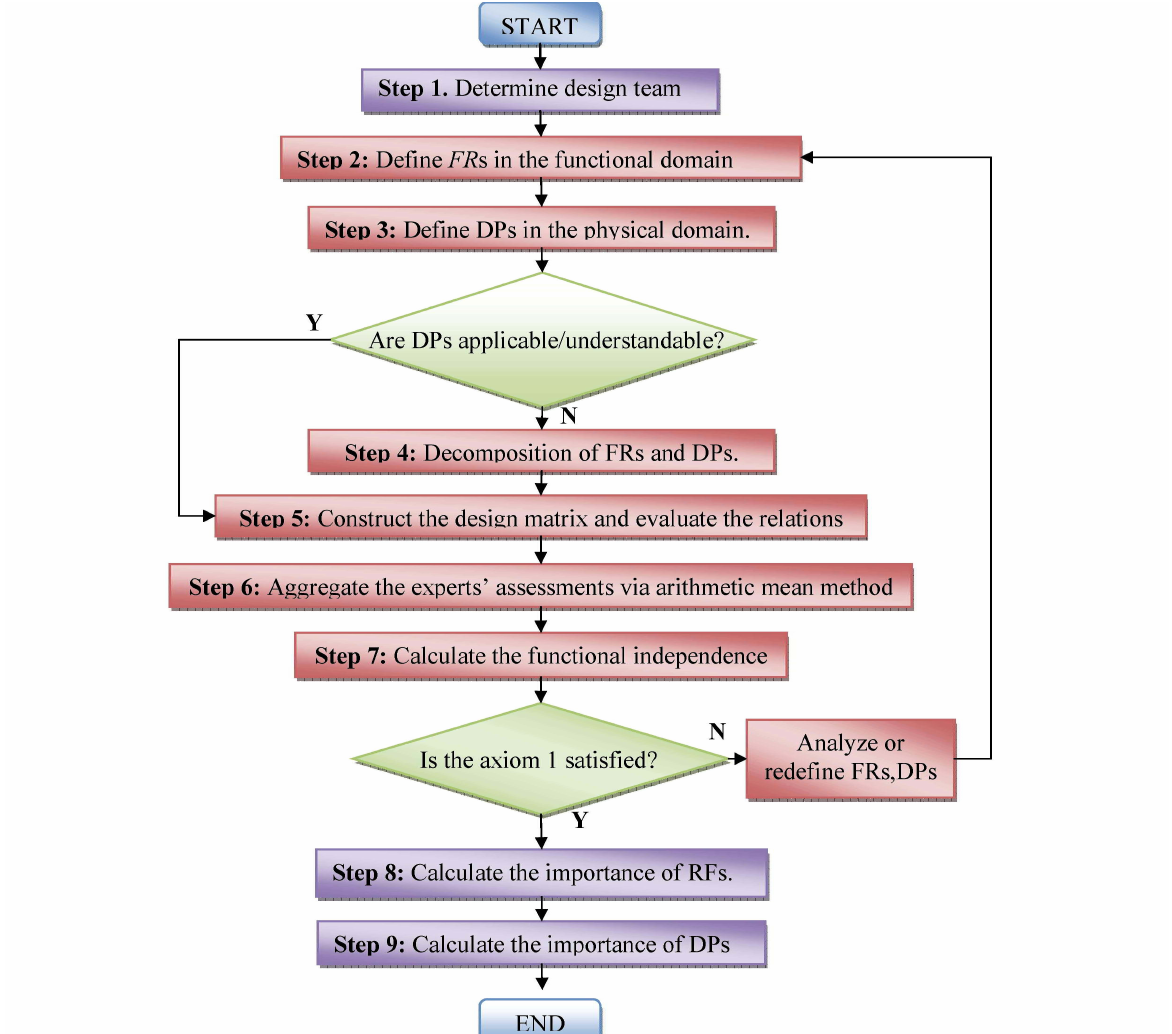
Figure 4. Framework of the proposed methodology